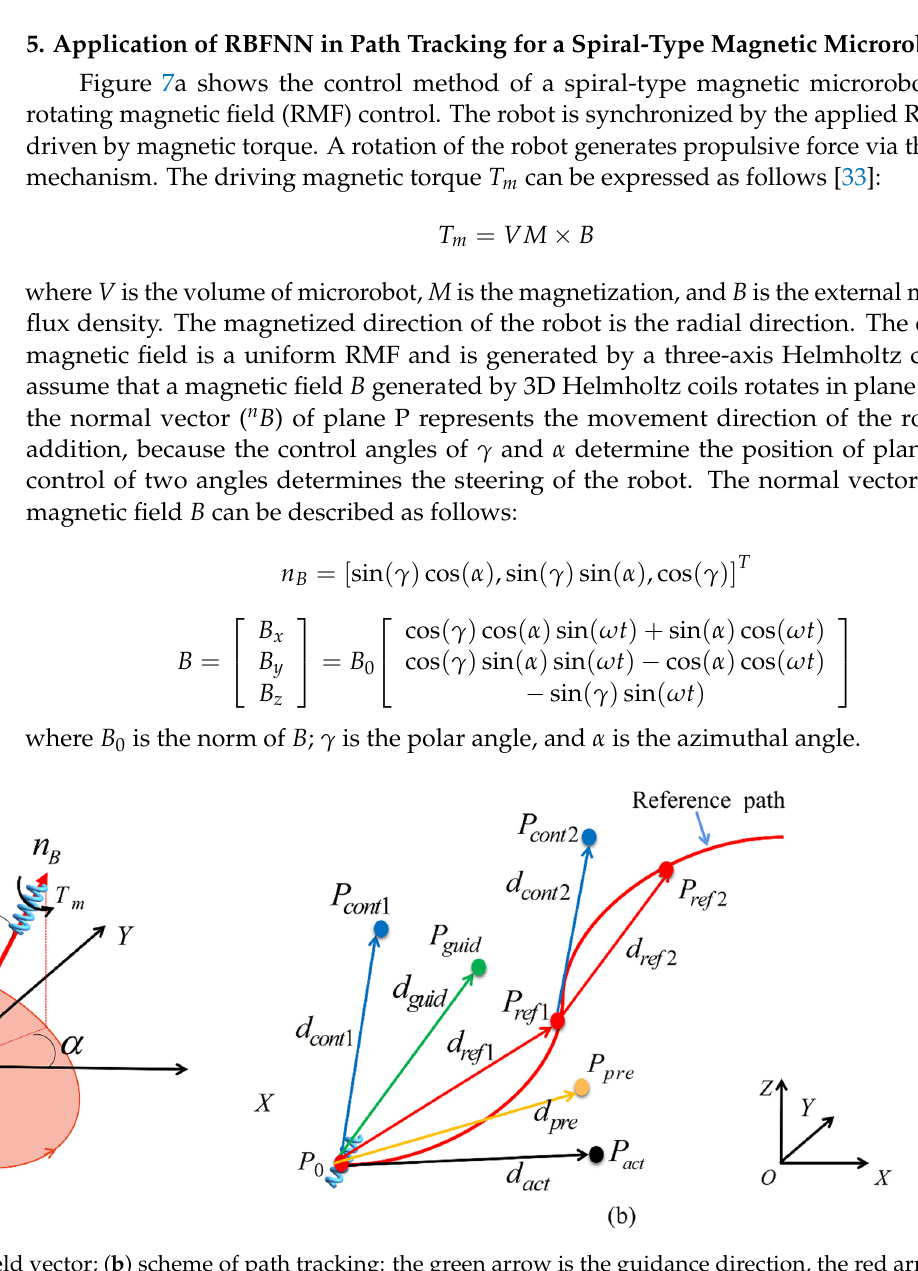
Figure 8. Scheme of RBFNN and control system: ( a ) structure of RBFNN for path tracking; ( b ) flow chart of control system. The input layer of RBFNN includes two neurons: reference angle